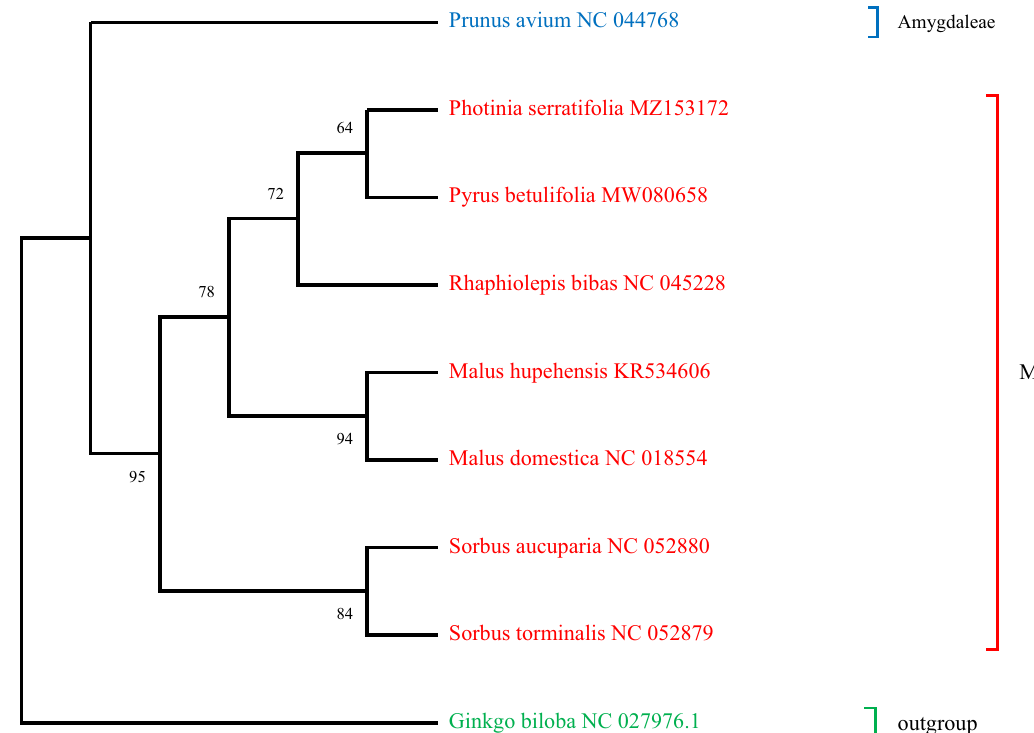
Figure 10. The phylogenetic relationships of P. serratifolia with other 8 plant species using the ML analysis. The bootstrapping values are listed in each node. The number after the species name is the GenBank accession number. Colors indicate the groups that the specific species